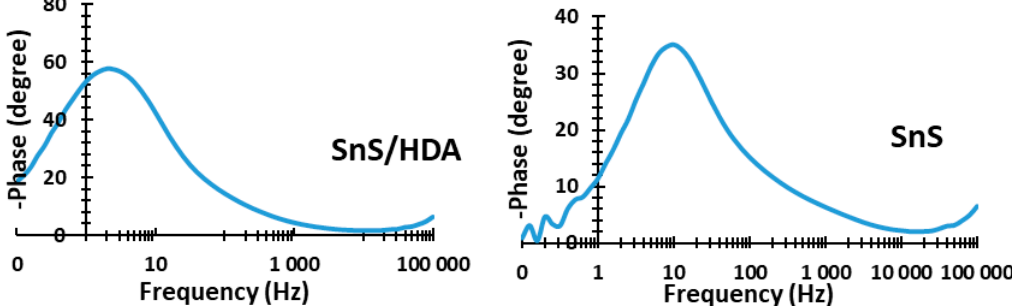
/ HDA and SnS nanoparticles.